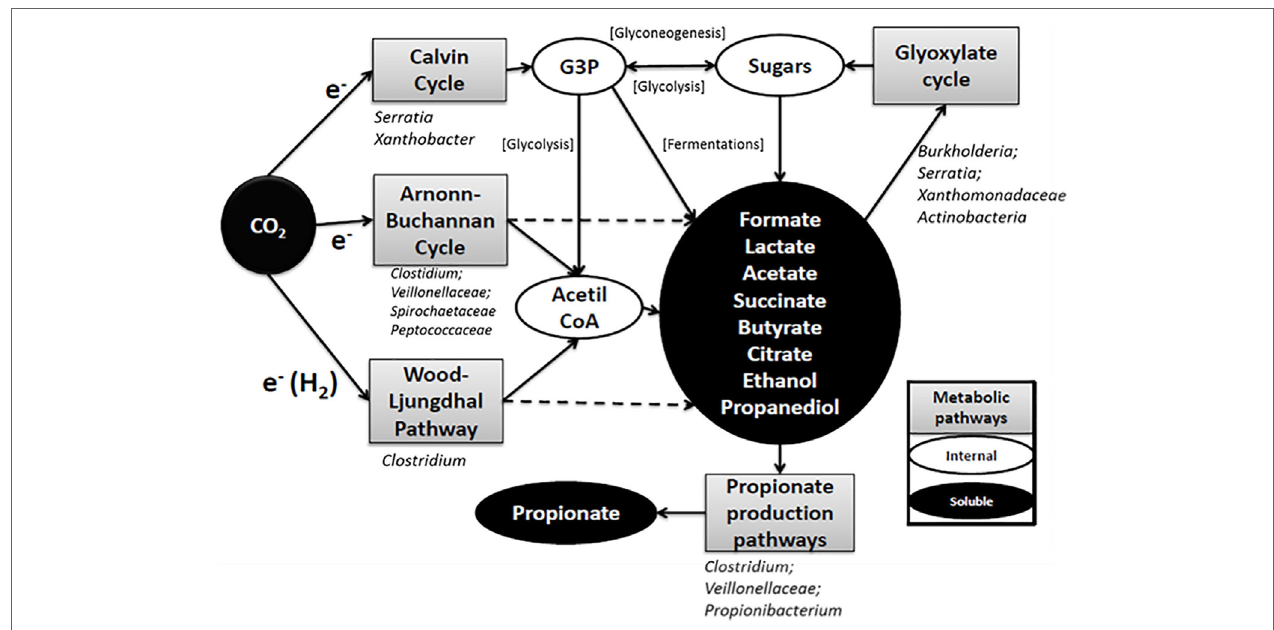
FigUre 6 | General scheme of the metabolic pathways involved in the production of organic compounds in the electrosynthesis cells according to PICRUSt analysis. Bacterial groups included under the pathway boxes are groups of microorganisms who contribute to the predicted genes in the PICRUSt analysis according to the operational taxonomic units classification. Some groups of microorganisms contributed to the abundance of particular genes but their abundance in the community was less than 1% (Table S1 in Data Sheet 2 in Supplementary